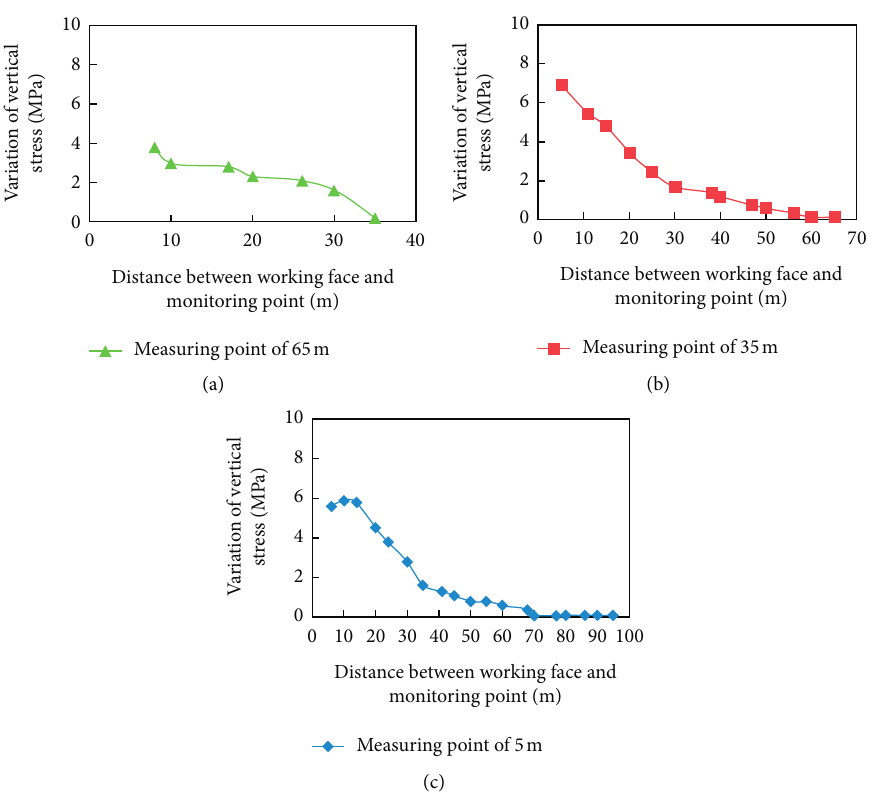
Figure 17: Borehole stress with working face advancing in ZuoQiuka coal mine. (a) Change of coal stress at 65m monitoring point. (b) Change of coal stress at 35m monitoring point (c) Change of coal stress at 5 m monitoring point.